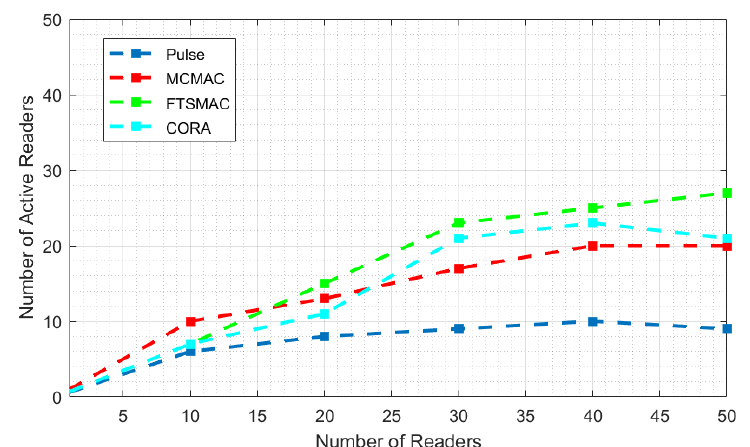
Figure 9 . Number of active readers vs. number of readers .